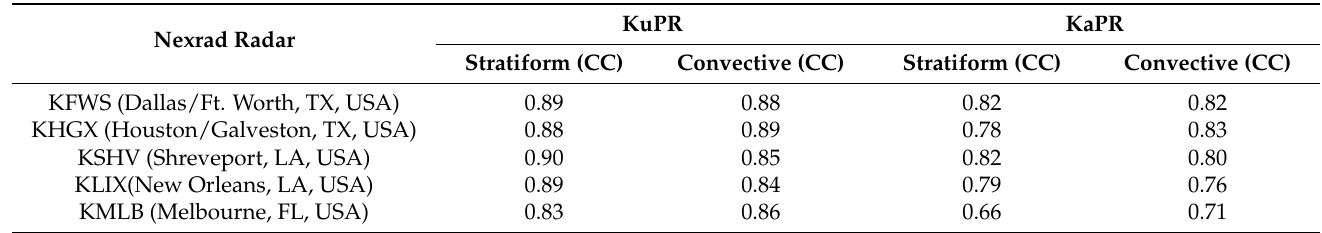
Table 7. Correlation coefficients for DPR Ku-band and Ka-band reflectivity vs. NEXRAD S-band reflectivity